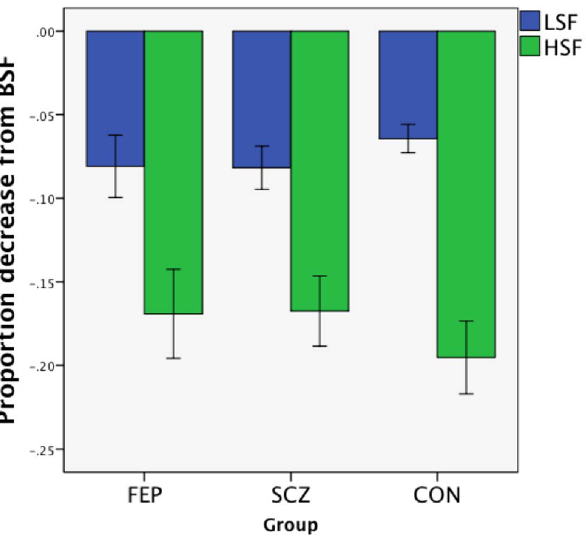
Fig. 2. Performance decrement from BSF, in LSF and HSF conditions, for each group, at Time 1. Error bars reflect + / 2 1 SE.